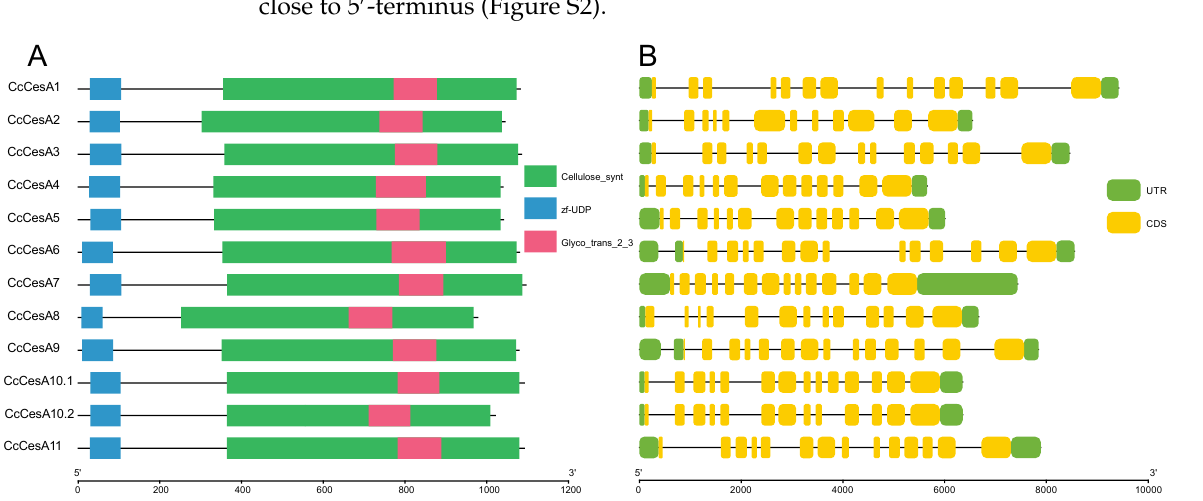
Table 3. Secondary protein structure of CcCesAs.